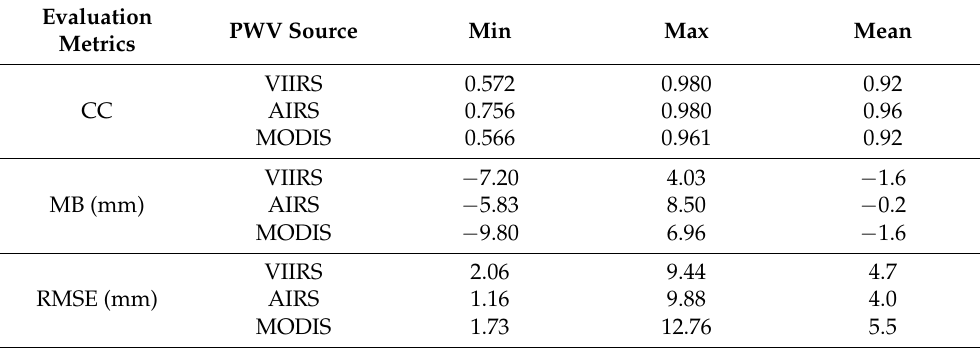
Table 2. The statistical results (i.e., the maximum, minimum, and mean values) of three evaluation metrics of the PWV data derived from the remotely sensed water vapor products compared with the GPS-PWV in mainland